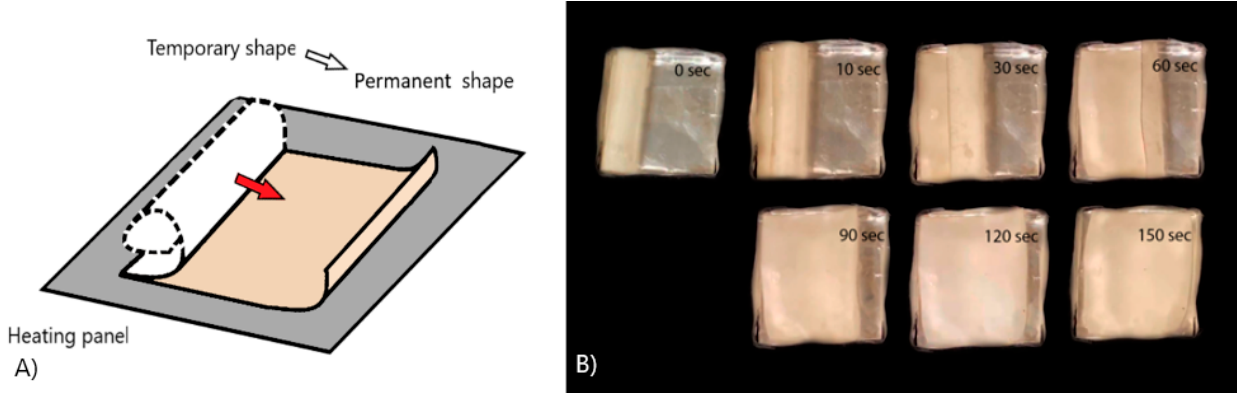
Figure 8. Scheme ( A ) and experiment ( B ) of gradual action of the SME in polymer blend PLA + 10%PCL.